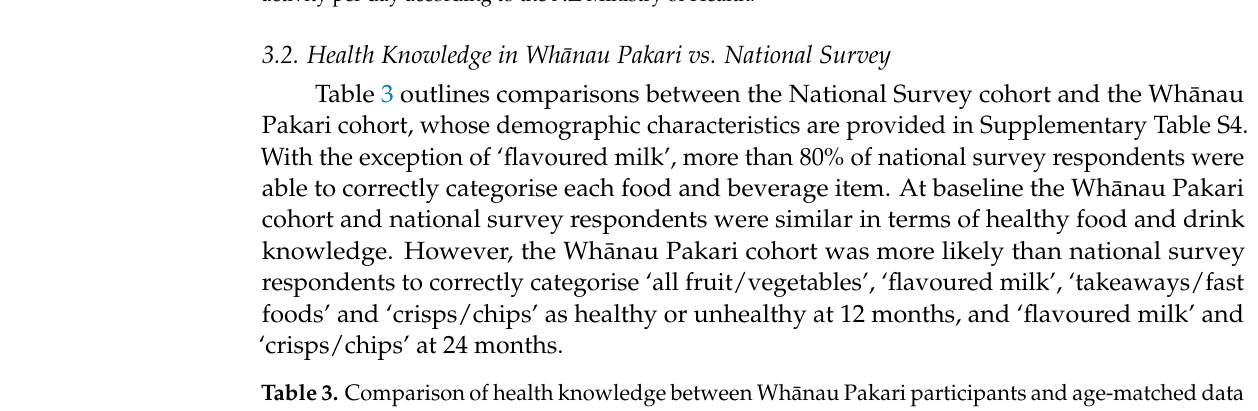
Table 3. Comparison of health knowledge between Wh¯anau Pakari participants and age-matched data from the National Survey of Children and Young People’s Physical activity and Dietary Behaviours in New Zealand